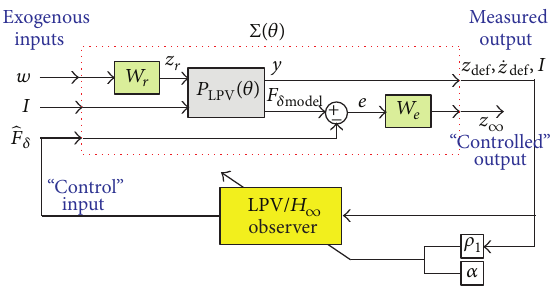
Figure 3: LPV/ 𝐻 ∞ observer design in a QoV model to estimate the faulty force caused by a damper leakage (inspired as a control